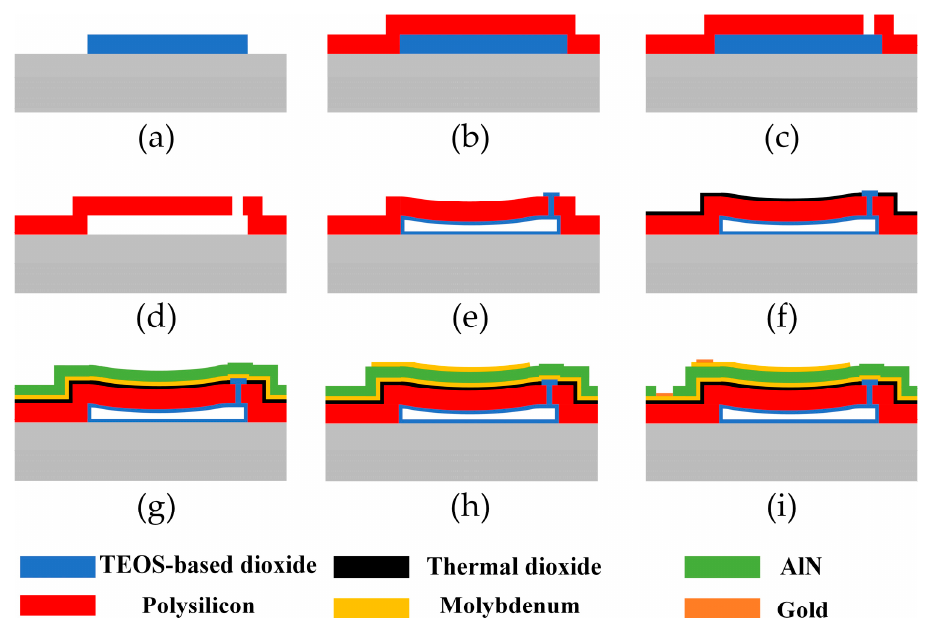
8. The top electrode film (0.2 µ m) of the molybdenum was fabricated to the wafer using the lift-off process. 9. Using photoresist as a mask, ion beam etching (IBE) was applied on the AlN film to form bottom electrode pads. For the convenience of wire bonding, a thin layer of gold (0.3 µ m) was deposited on the pad using the lift-off process.